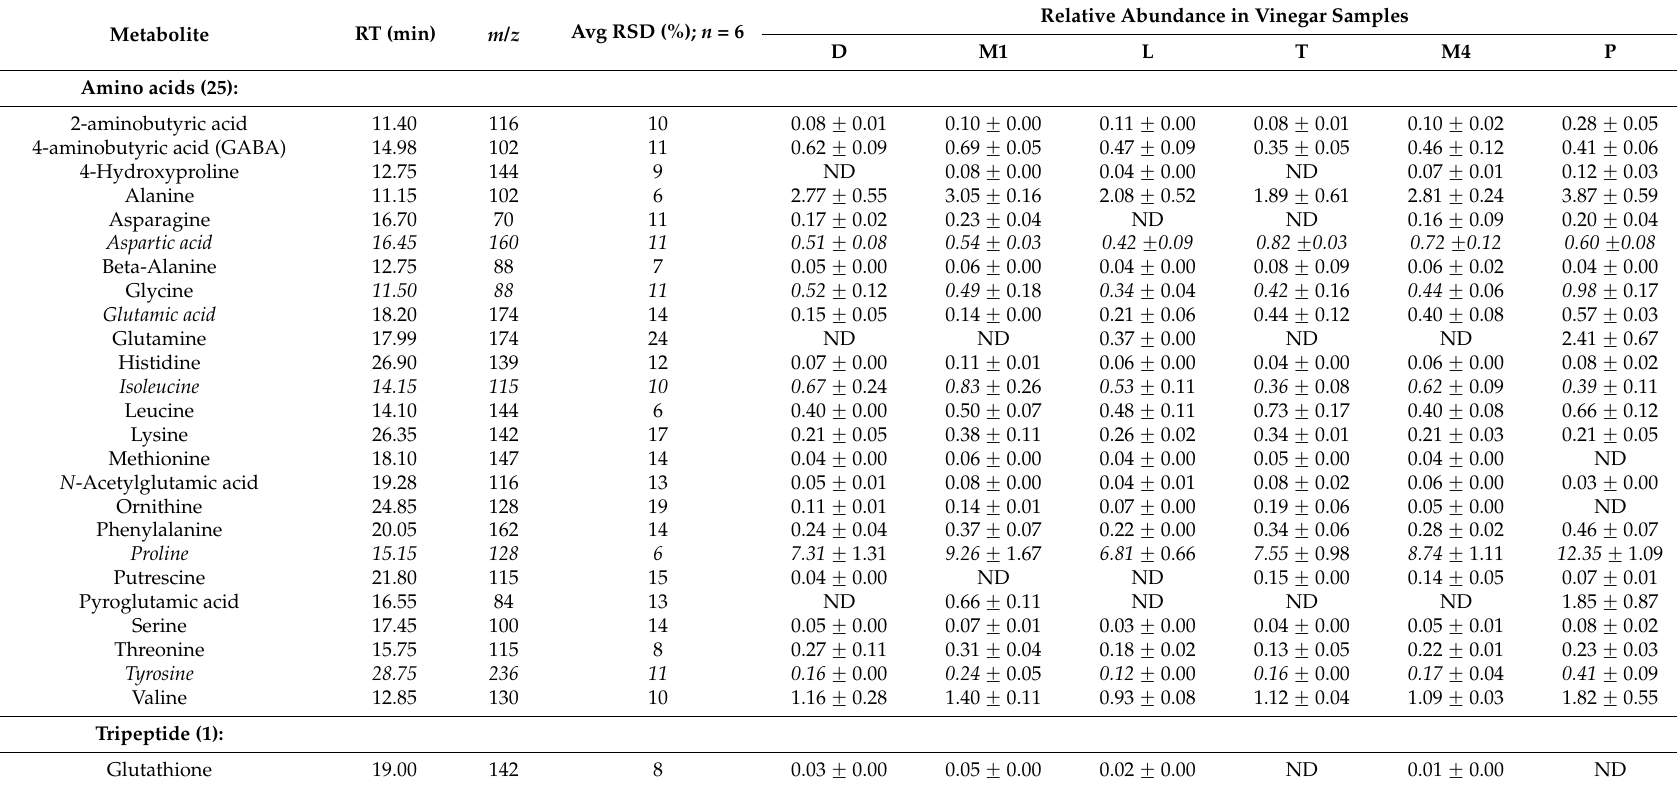
Table 1. Features and levels of non-volatile metabolites detected and identified in balsamic